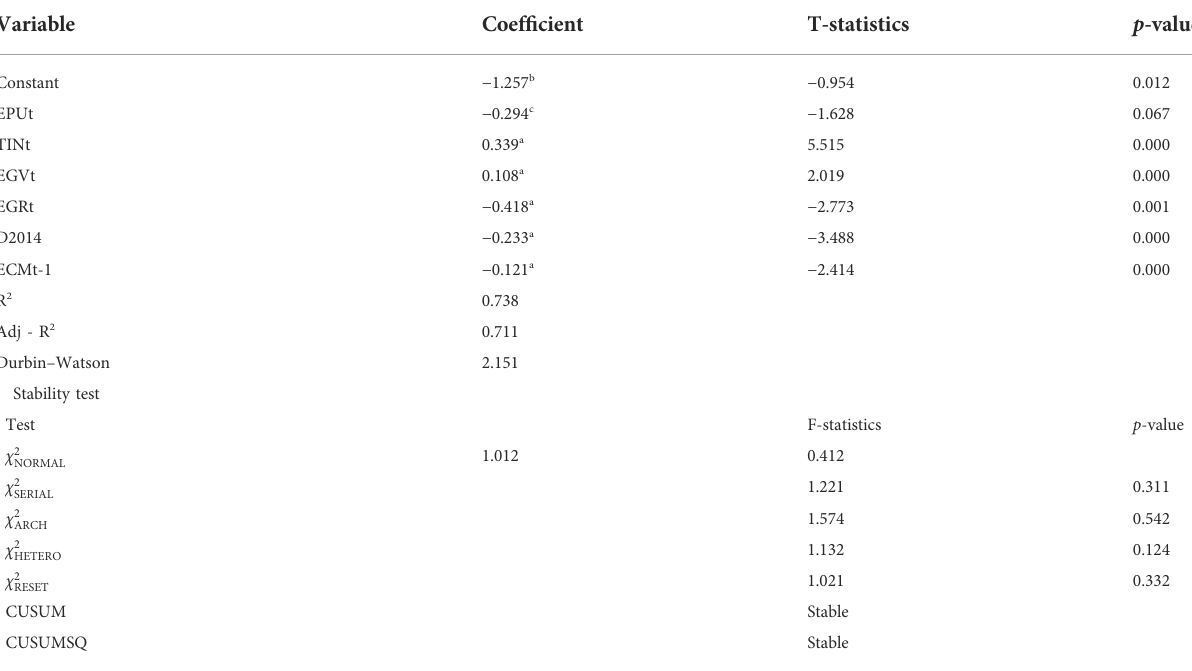
TABLE 6 BARDL cointegration analysis: short-run fi ndings. Dependent variable =